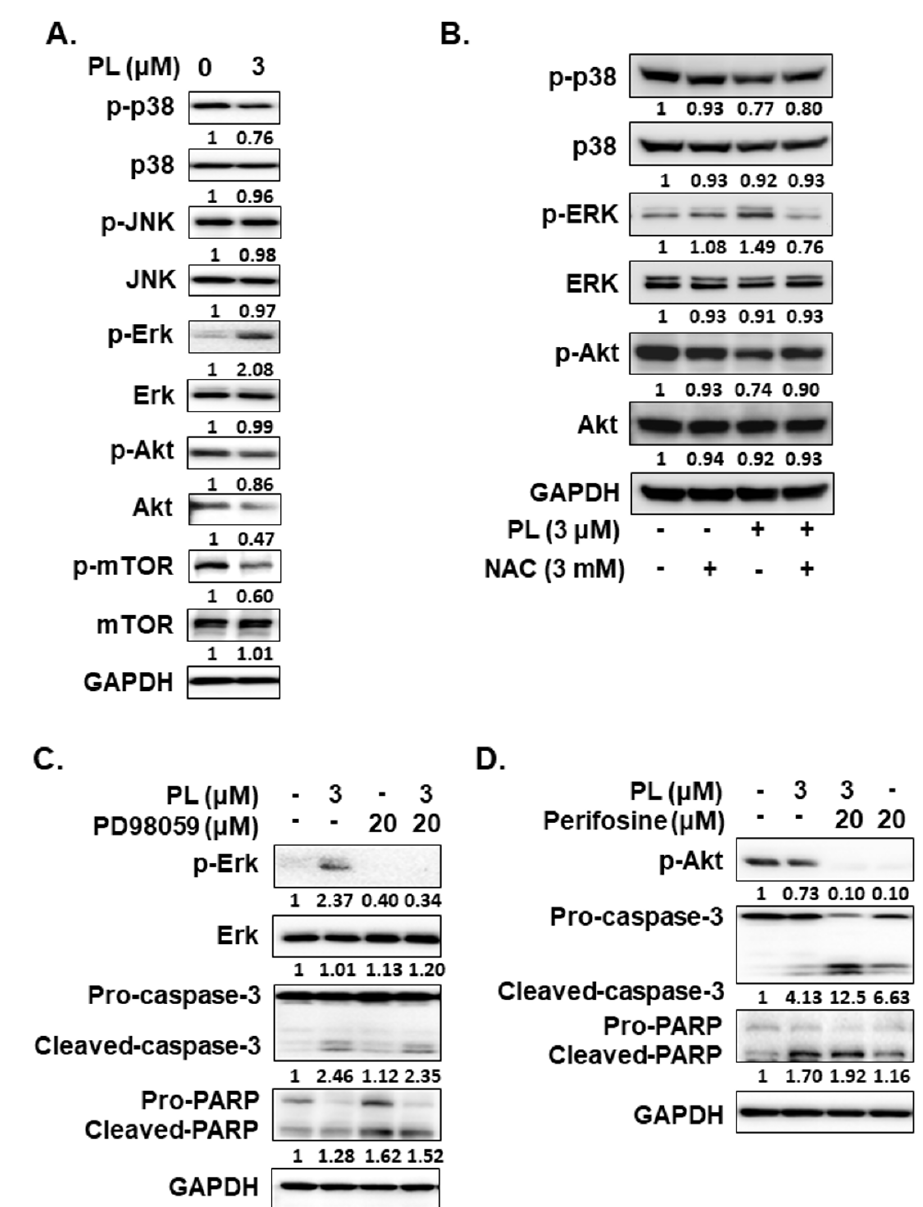
Figure 6. Regulation of the activation of the Erk and Akt signaling pathways by piperlongumine (PL) through reactive oxygen species (ROS) induction. KMH-2 cells were used to evaluate the regulation of signaling pathways under PL treatment. ( A ) The expression and the activation of Erk, JNK, p38, Akt, and mTOR were examined by western blotting in PL-treated cells. ( B ) NAC was used to block PL-mediated ROS induction and p38 activation, and the resulting expression of Erk and Akt was examined by western blotting. ( C ) PD98059 was used to suppress PL-mediated Erk activation, and ( D ) perifosine was used to promote PL-mediated Akt activation, and the activation of caspase-3 and PARP was examined by western blotting. DMSO was used as a negative control. GAPDH was used as a loading control. Three independent experiments were conducted, and a representative experiment is shown.